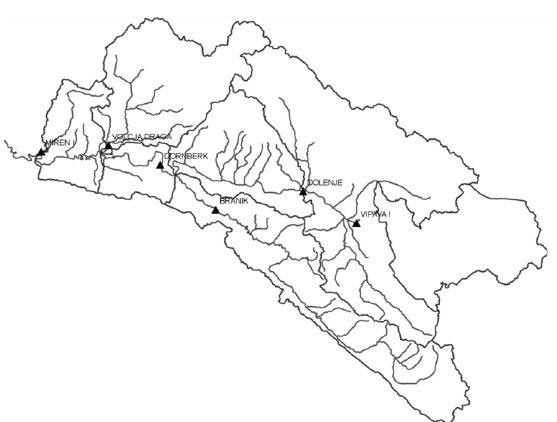
Fig. 2 Sub watersheds for hydrological model and water stations used for modelling.